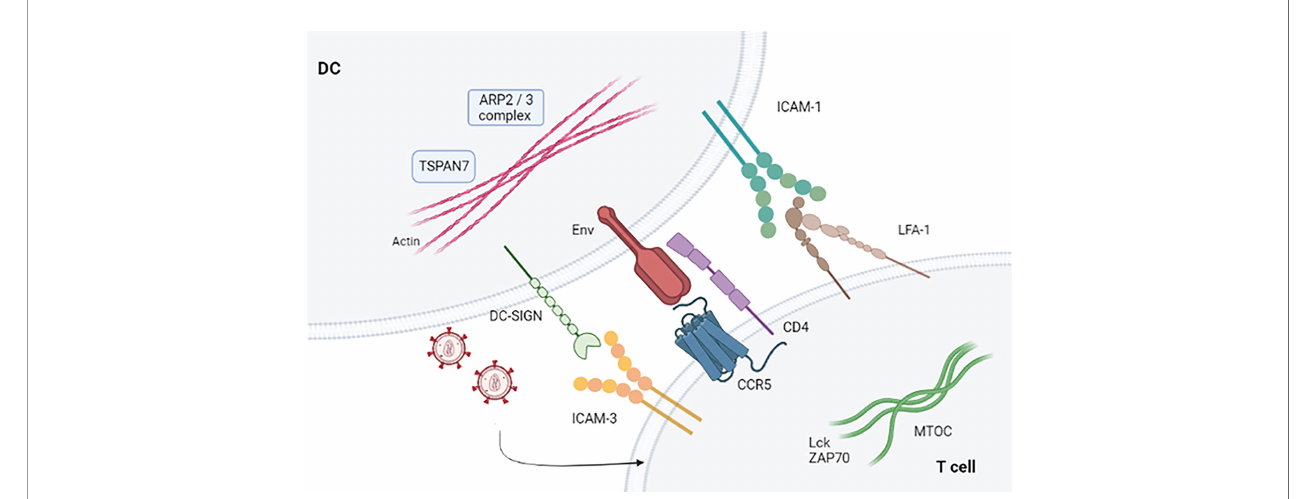
FIGURE 2 | Virological synapse in the presence of HIV-1. Virological synapse in the presence of HIV. The interaction between the different receptors present in both DCs and T cells allows entry into the target cells (CD4+ T and CD8+ T lymphocytes), thus allowing the dissemination of HIV-1 that escapes the immune response mechanism produced by these